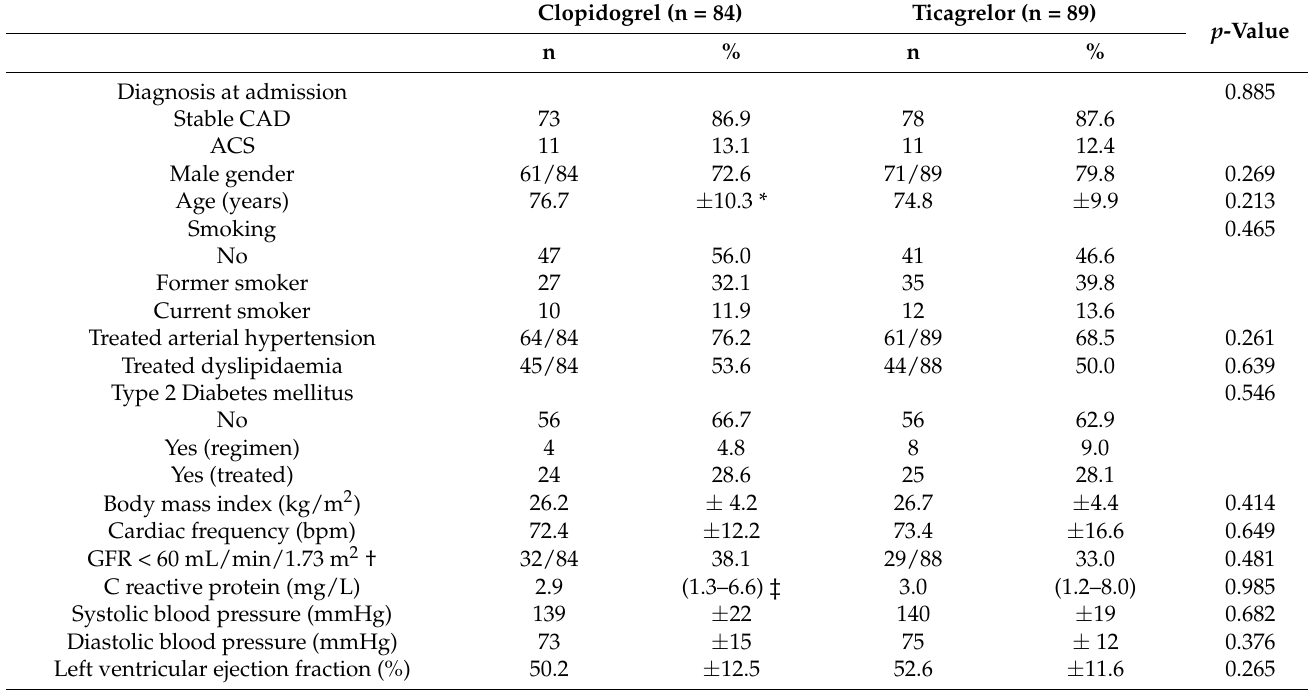
Table 1. Baseline characteristics.